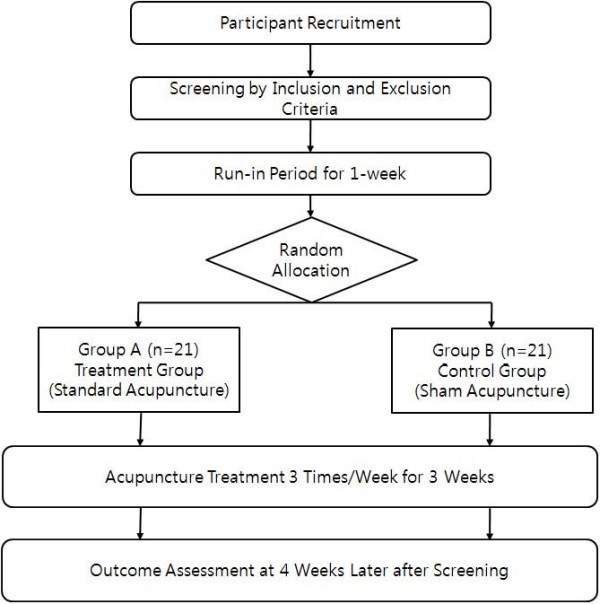
Study Flow Chart.